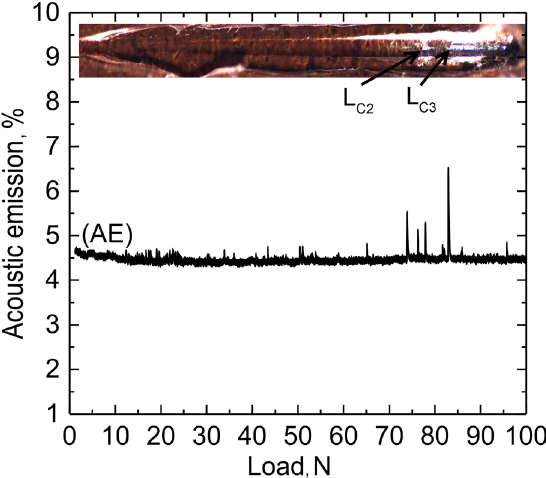
Figure 14. The photograph of the HC - 1,2,4 - tr sample after the scratch test and the dependence of acoustic emission (AE) on the load on the indenter at a speed of 12 N min −1 .